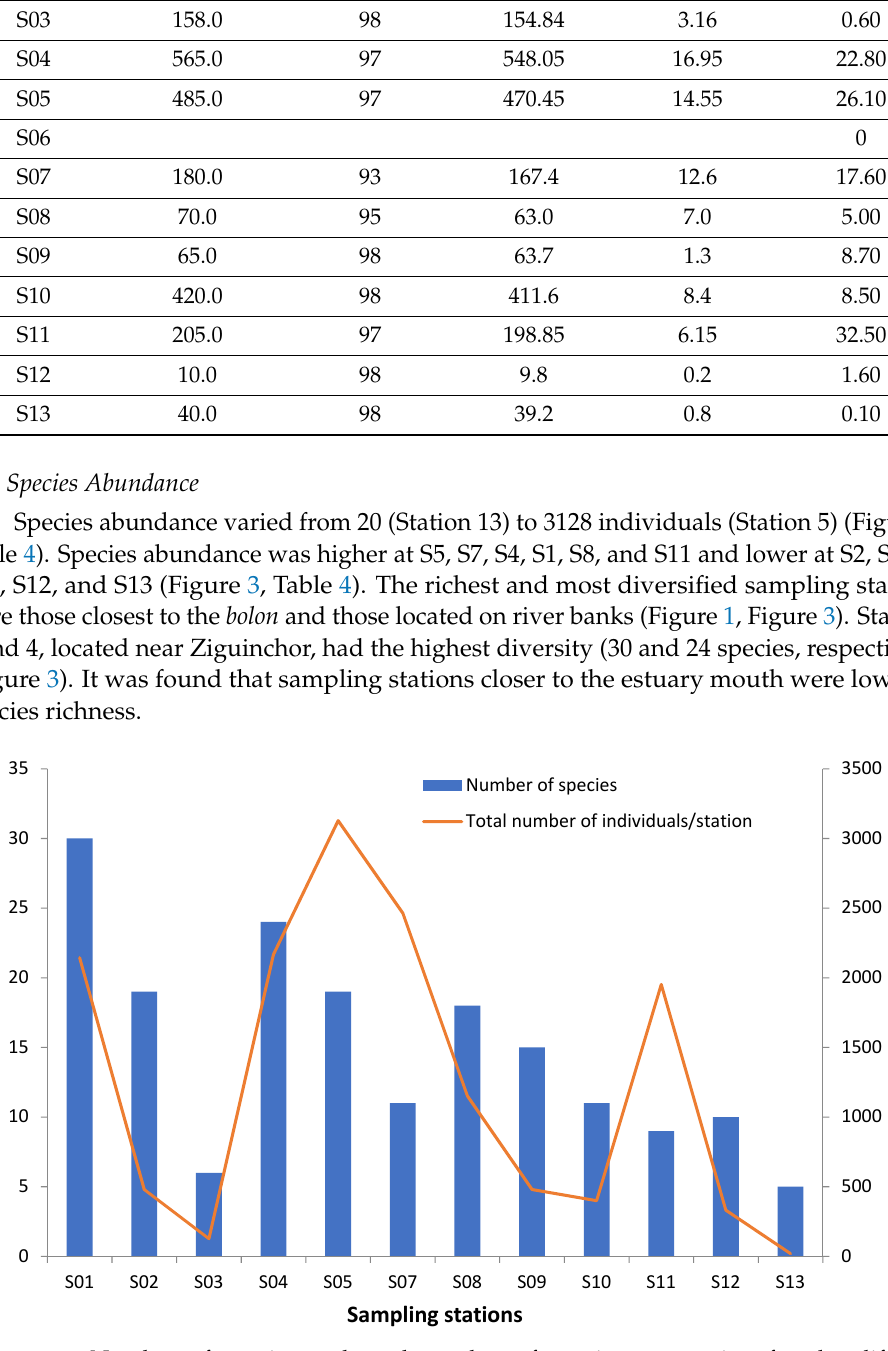
Figure 3. Number of species and total number of species per station for the different sampling sta ‐ tions. Table 4. Diversity and evenness of benthic wildlife at the thirteen sampling stations (1 to 13) of the road channel from the mouth of the Casamance estuary to Ziguinchor. Total Number of Indi ‐ Stations Number of Species viduals/Station 0.311 3.5. Shannon ‐ Weaver and Pielou Indexes The benthic biodiversity per station, measured using the Shannon ‐ Weaver index, is indicated in Figure 4 and Table 4. The average Shannon index varied significantly be ‐ tween 0.770 and 2.772 ( t ‐ test: t = 6.2332; df = 803; p = 7.375×10 − 10 ). The highest values were observed at Stations 1 and 2, followed by Stations 5, 4, and 8 (Figure 4, Table 4). The index was lower at Station 11 (Figure 4, Table 4). The Pielou index per station, calculated from the ratio of the average Shannon indexes and the number of species, are indicated in